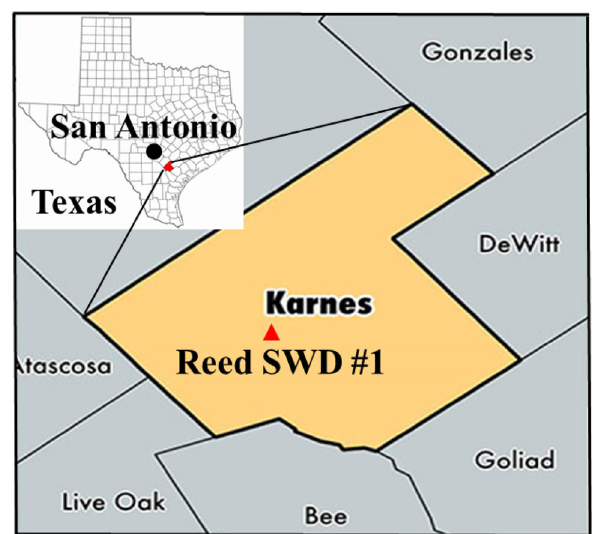
Fig. 4 Approximated location of Karnes injection site